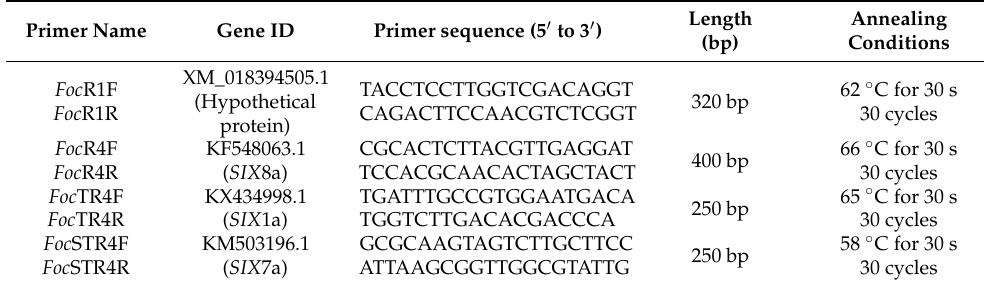
Table 2. List of Foc race-specific primers used in this